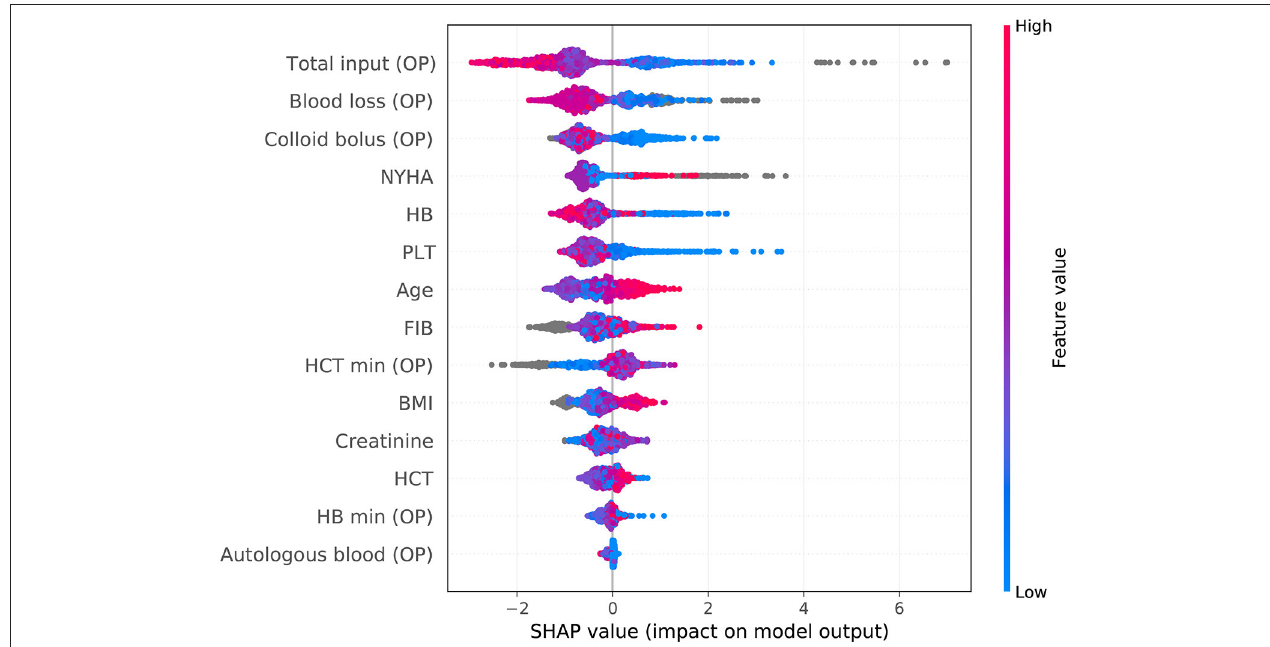
FIGURE 3 | SHAP analysis of the proposed model on the whole cohort. This figure described data from the whole cohort, with each point representing one patient. The color represents the value of the variable; blue represents the smaller value, and red represents the larger value; the horizontal coordinates represent a positive or negative correlation with severe complications risk, with a positive value indicating a good outcome and a negative value indicating a risk of severe complications. The absolute value of the horizontal coordinate indicates the contribution of variables; the greater the absolute value of the horizontal coordinate, the greater the contribution of the